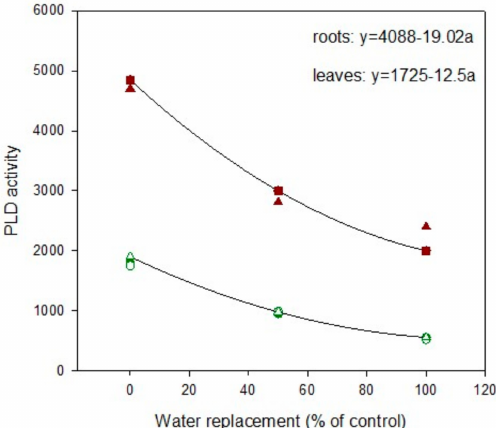
Figure 3. Correlation plots between percentage of water loss replacement and PLD activity at the end of the three-week experiment in roots (brown plot) and leaves (green plot). Three individual replicates were plotted for each water loss replacement value. The experiment was repeated three independent times with similar results.